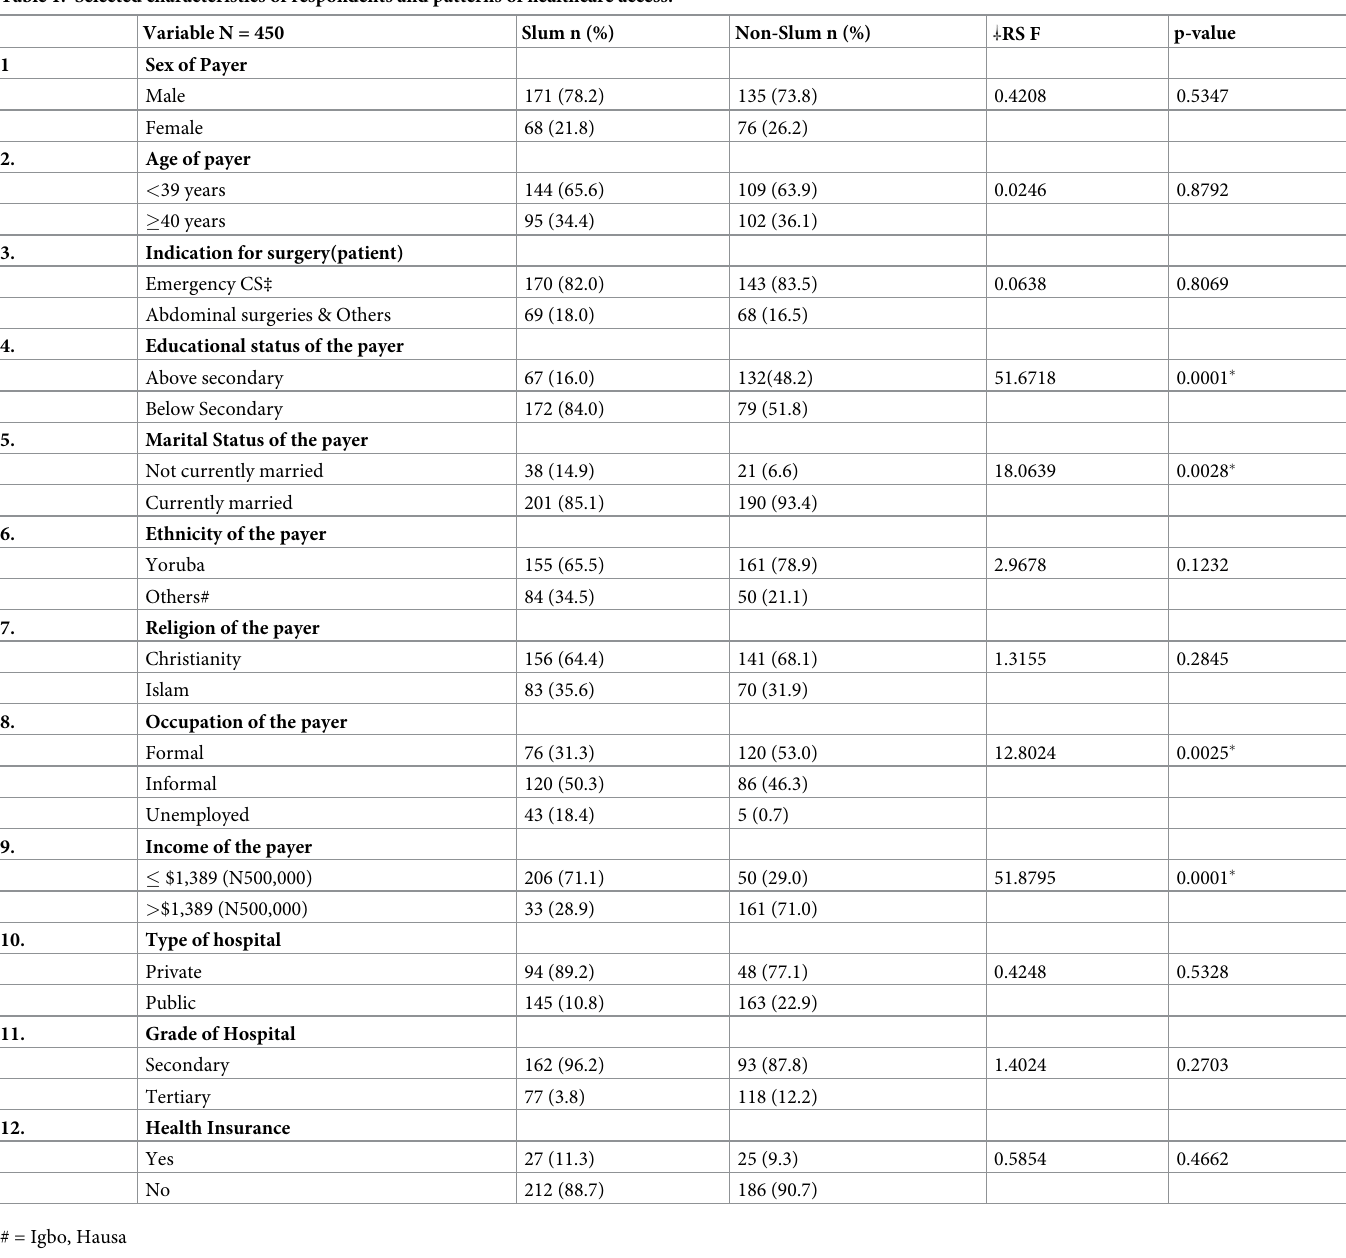
Table 1. Selected characteristics of respondents and patterns of healthcare